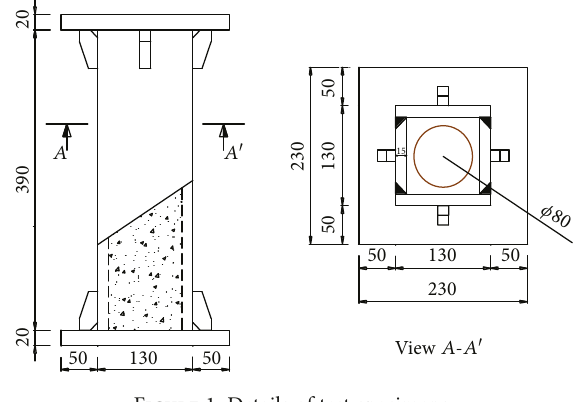
Figure 1: Details of test specimens. Table 1: Variables and details of test